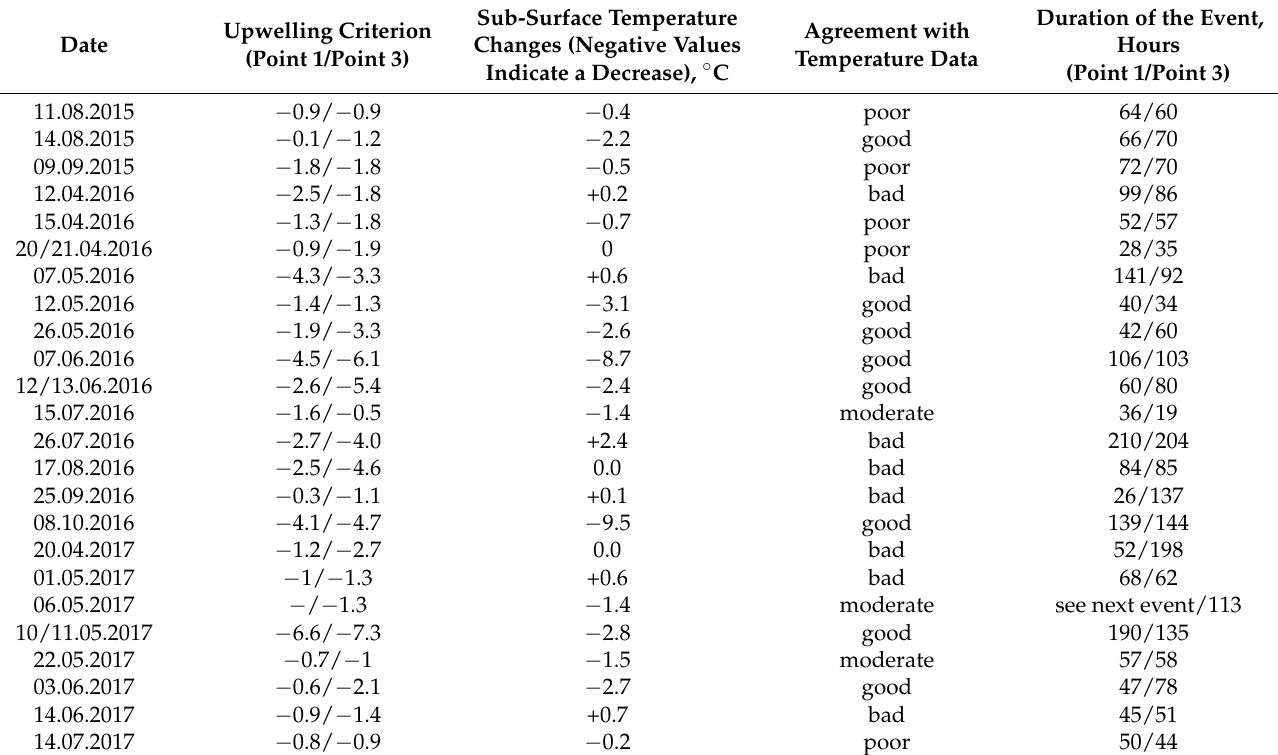
Table 1. Events with an upwelling criterion of less than −1 and observed temperature change.